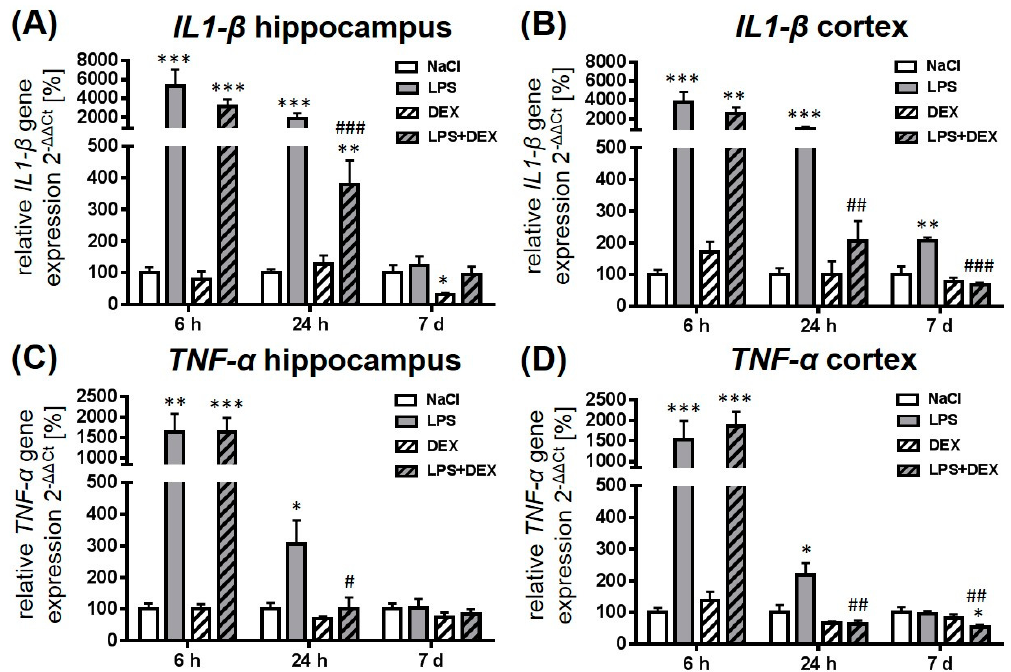
Figure 1. Representation of interleukin 1- β (IL1- β ) ( A , B ) and tumor necrosis factor- α ( TNF- α ) ( C , D ) gene expression after LPS (lipopolysaccharide) and dexmedetomidine treatment. Results are shown as mean ± standard error of the mean (SEM) ( n = 6–8 per group). Data are normalized to levels of saline-treated rats (control = 100%). * p < 0.05, ** p < 0.01, and *** p < 0.001 represent the difference compared to saline-treated groups. # p < 0.05, ## p < 0.01, and ### p < 0.001 represent the difference between LPS and LPS in combination with dexmedetomidine-treated groups.